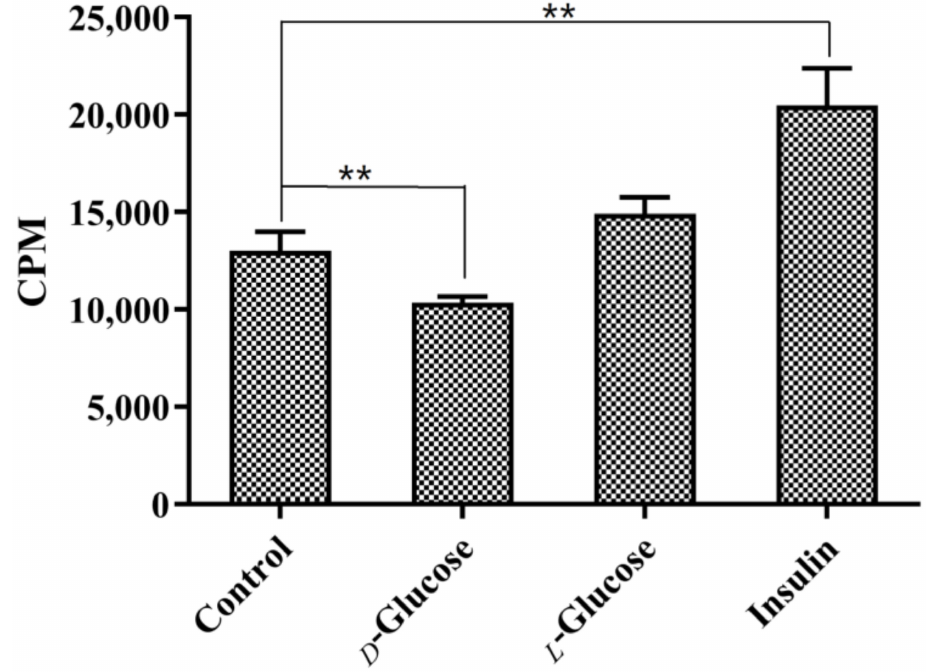
Figure 3. In vitro cellular uptake of [ 99m Tc]Tc-CNMCHDG in A549 tumor cells (** p < 0.01, n =